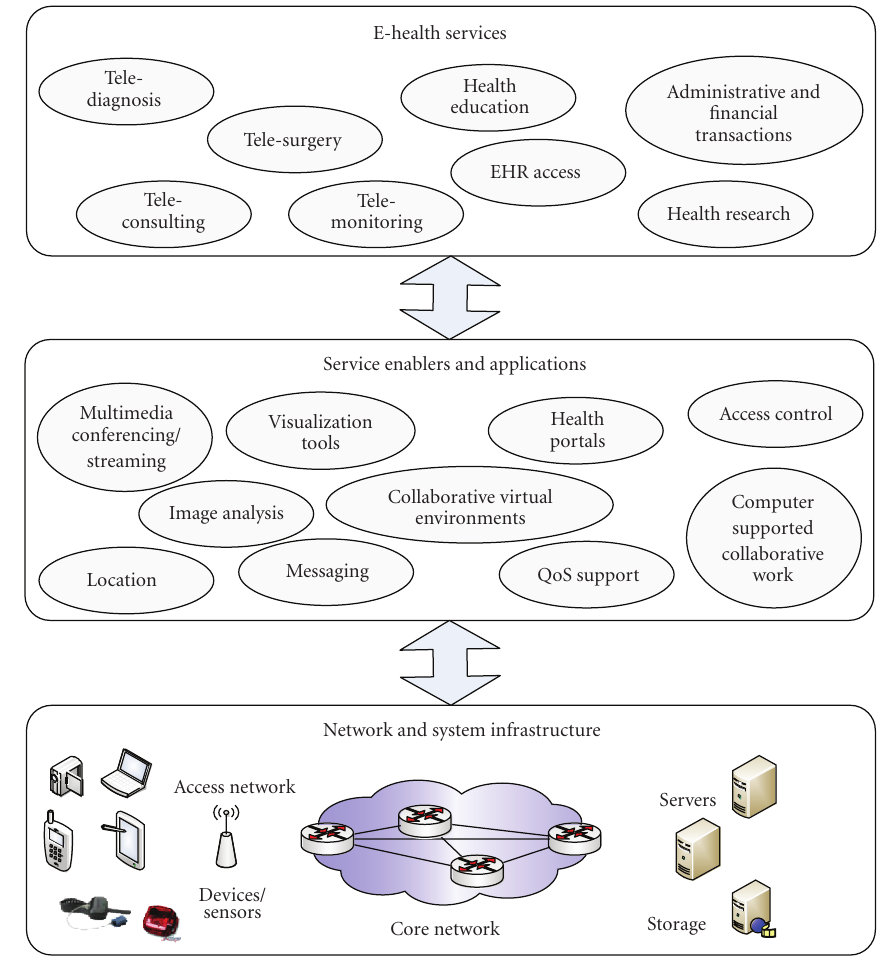
Figure 1: Layered service environment for e-Health